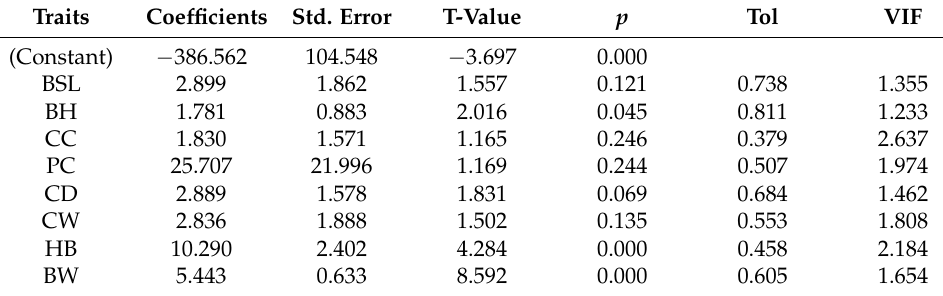
Table 4. Multiple linear regression analysis results.